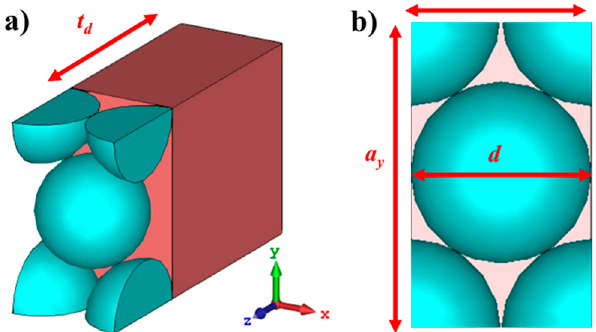
Figure 2. The layout of the computational unit cell of a close-packed hexagonal monolayer of dielectric spheres on a dielectric substrate: ( a ) perspective view and ( b ) top view.